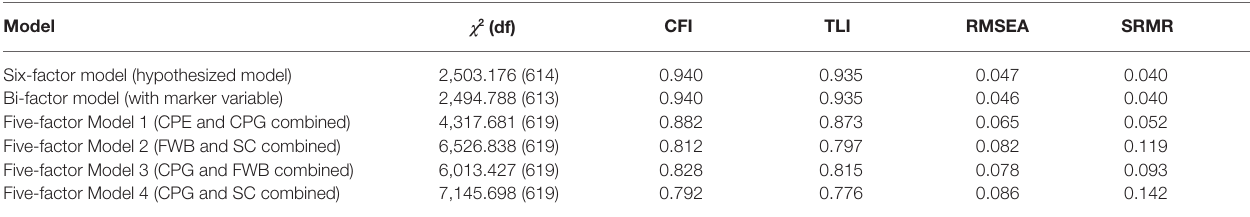
TABLE 2 | Results of confirmatory factor analysis (CFA) and test for common method variance. Model